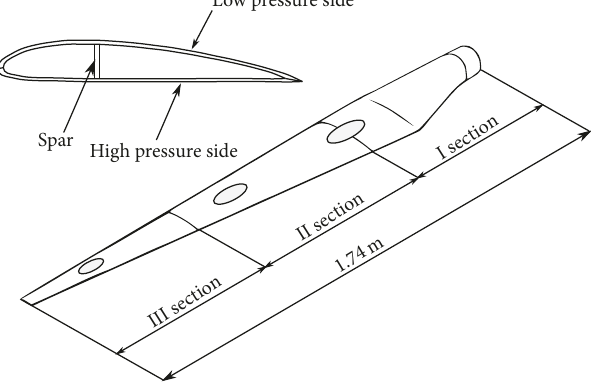
Figure 3: A scheme of a scaled-down wind turbine rotor blade.